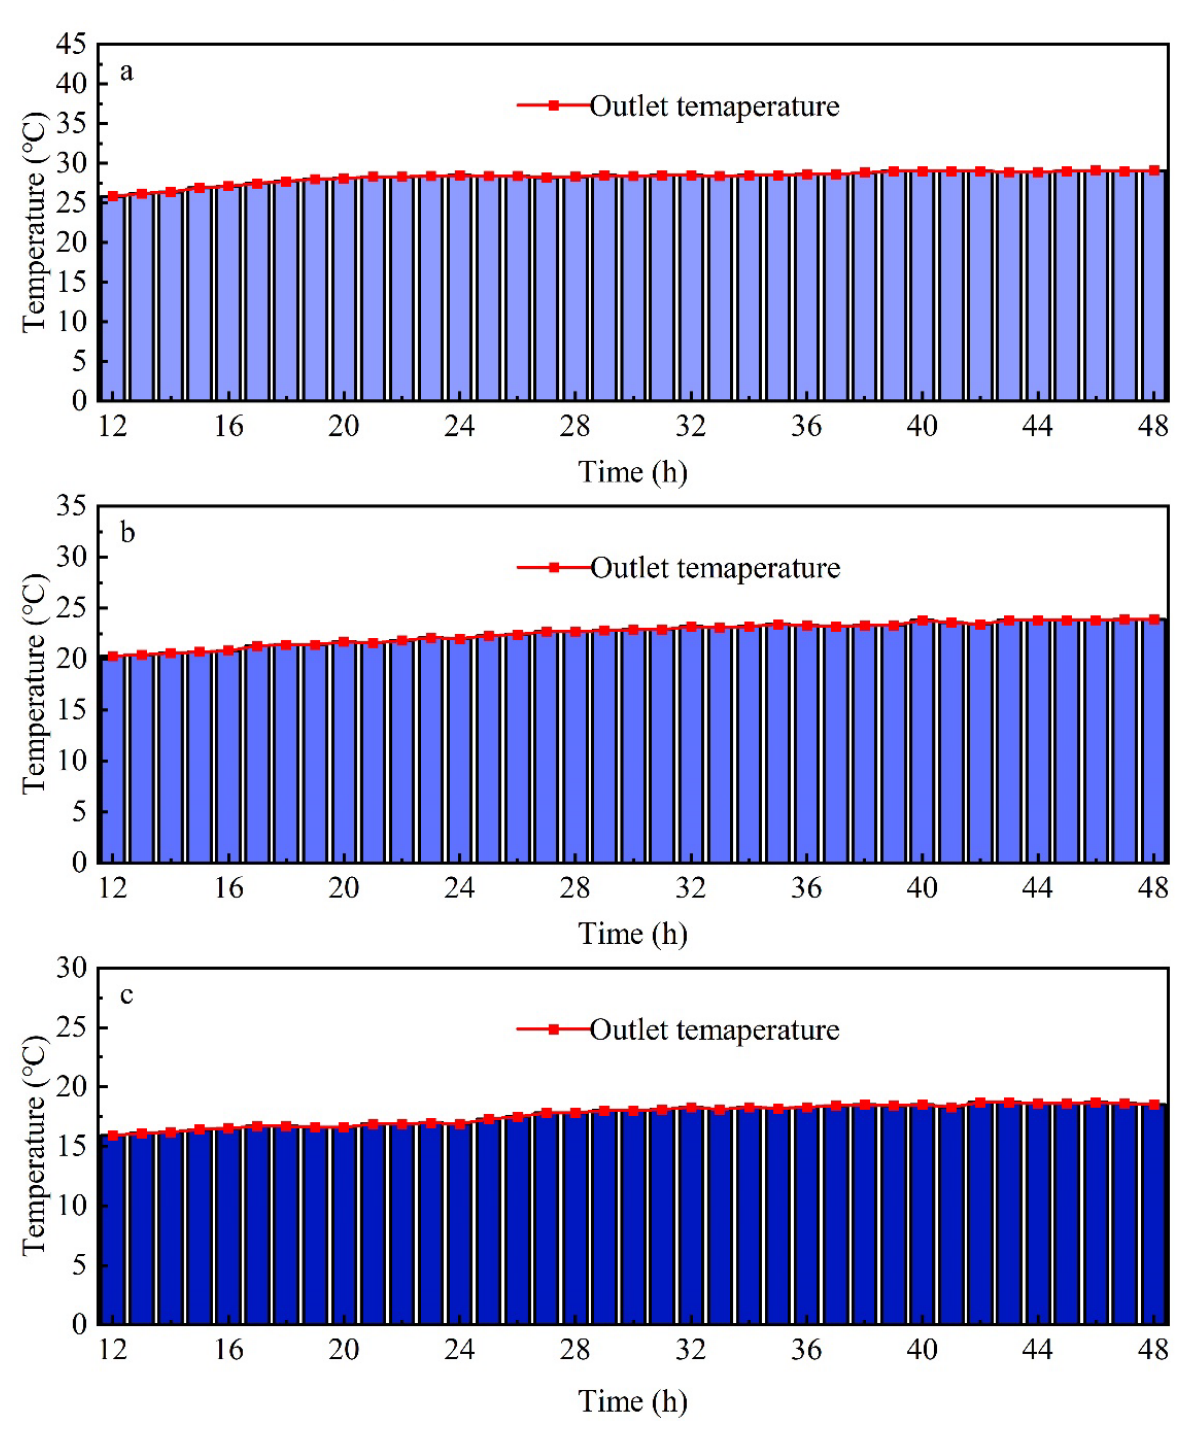
Figure 6. Change in the outlet temperature of the heat exchanger. ( a ) Condition A. ( b ) Condition B. ( c ) Condition C.